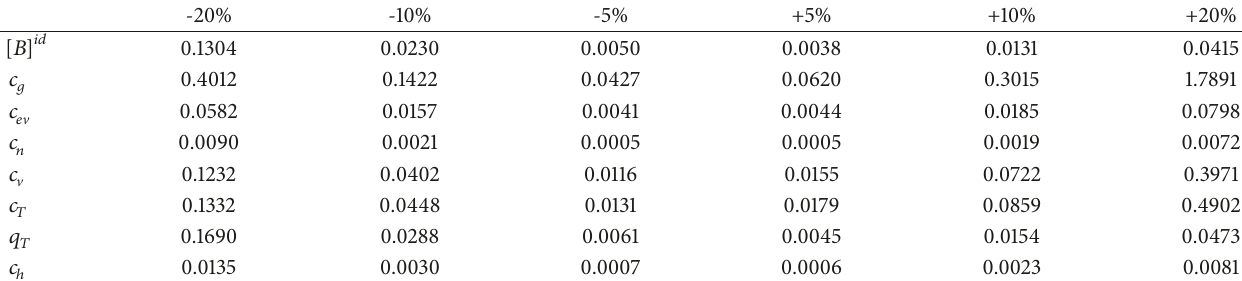
Table 7: Sensitivities ( 𝑆 ) of the model to the changes of parameters [𝐵] 𝑖𝑑 , 𝑐 𝑔 , 𝑐 𝑒 V , 𝑐 𝑛 , 𝑐 V , 𝑐 𝑇 , 𝑞 𝑇 , 𝑐 ℎ , 𝑞 𝐼 , and 𝑘 𝑉 in the case of therapy 2. One unit is 10 7 mm 3